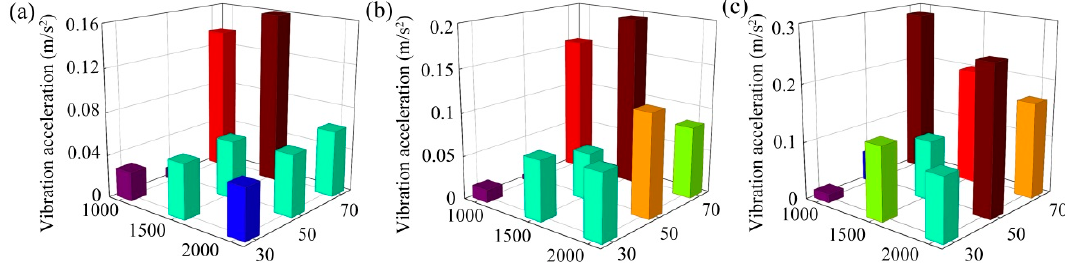
Figure 9. The mean value of vibration acceleration in the three directions: ( a ) X-direction, ( b ) Y- direction, and ( c ) Z-direction.